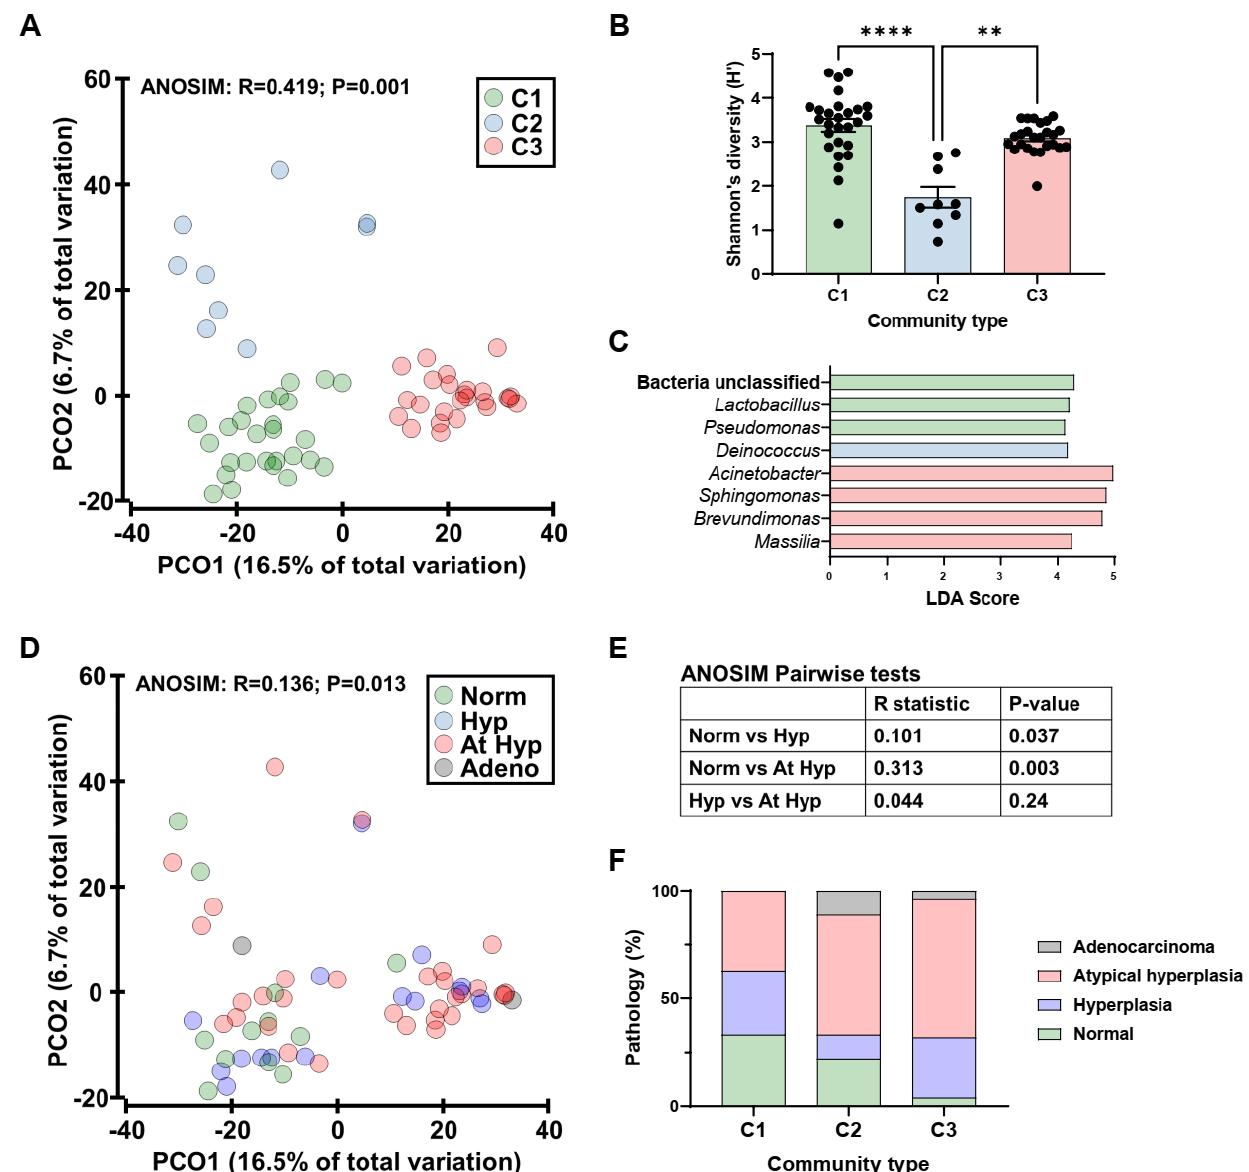
Figure 4. Endometrial microbiota of mice on chow or a western diet. ( A ): Principal coordinate (PCO) analysis of bacterial beta diversity across community types (C1–C3). The ordinations were generated from Bray-Curtis resemblance matrices on square-root transformed bacterial relative abundances.